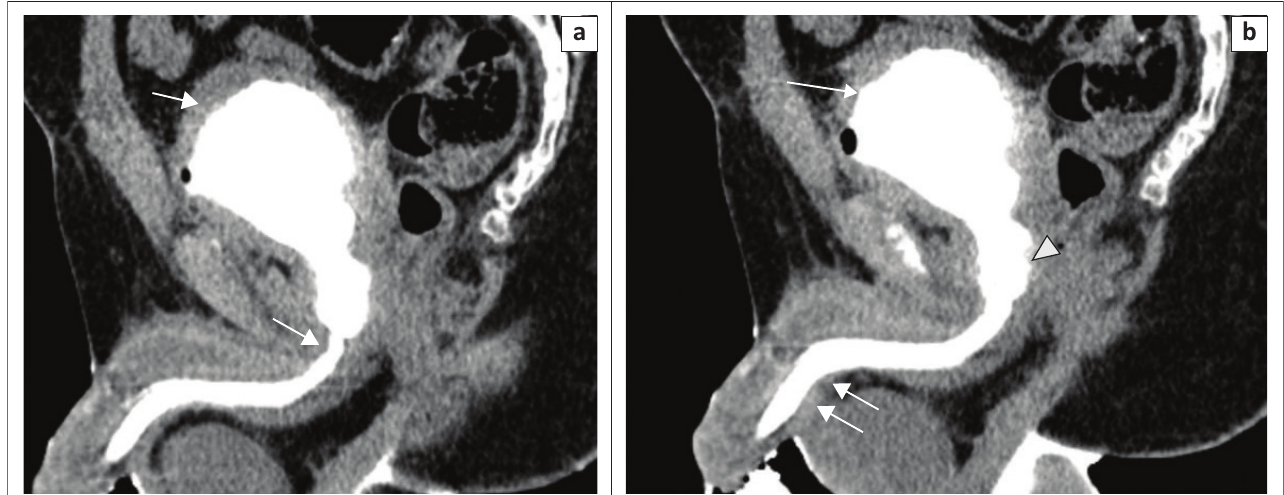
FIG URE 7: Sagittal multiplanar reformatted images: (a) Partial stricture (short arrow) at the bulbomembranous junction, with a dilated proximal urethra. Small-sized bladder with cystitis (arrow) and posterior urethritic changes (irregularities in urethral wall) (arrowhead) are noted. (b) Extravasation into the periurethral soft tissues noted at the level of mid-penile urethra (double arrows).